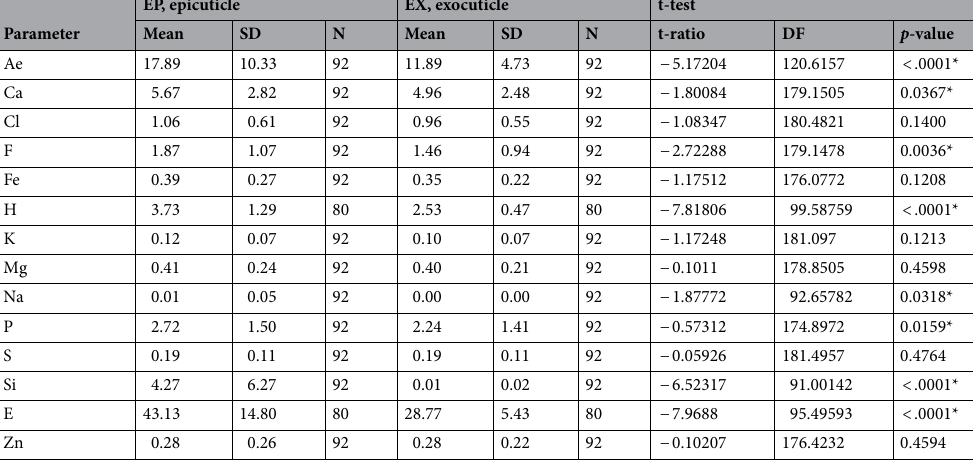
Table 2. Left: The mean and SD of the mechanical properties (H and E, both in GPa) and elemental proportions (in atomic %) for the epi- and exocuticle (all structures pooled together). Right : Pairwise comparison between epi- and exocuticle for each parameter performed by t-test. E Young’s modulus, EP epicuticle, EX exocuticle, H hardness, N quantity of test, SD standard deviation.